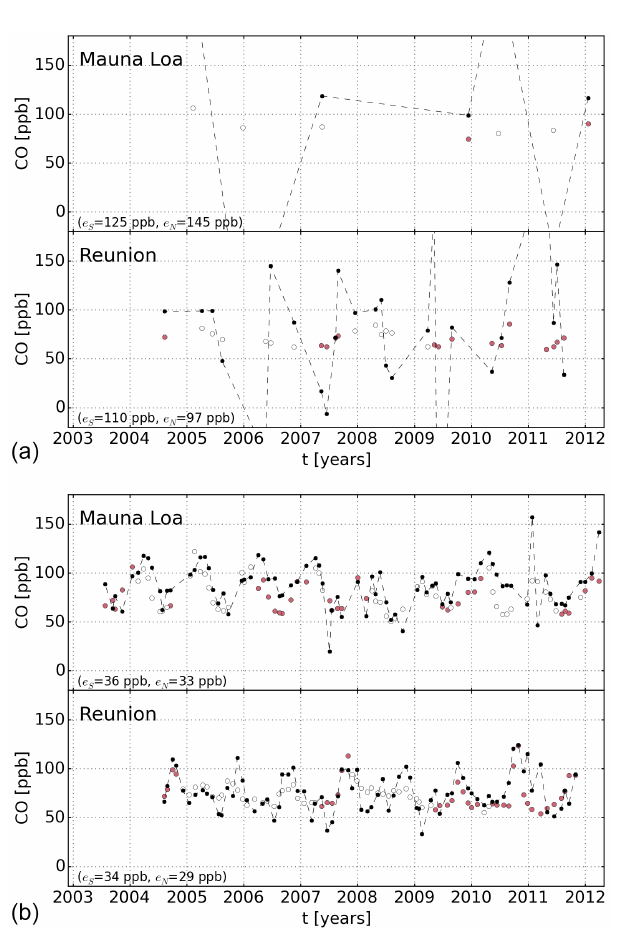
Figure 8. 30-day median of CO column averaged mixing ratios measured by SCIAMACHY (black) and at two NDACC-IRWG stations (pink). (a) SCIAMACHY clear-sky retrievals, (b) SCIA- MACHY cloudy-sky retrievals with optical thick low clouds. Open circles denote interpolated values for periods in which no NDACC- IRWG measurements are available. The scatter (cid:15) S and the mean retrieval noise (cid:15) N for individual retrievals in the monthly bins are shown.